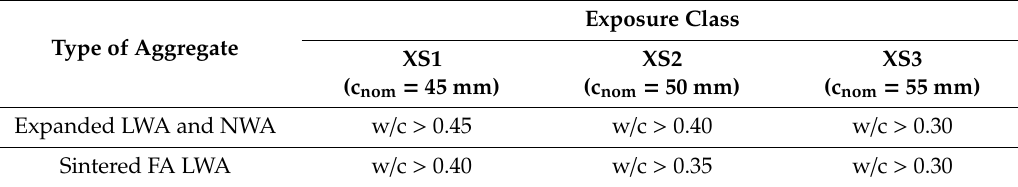
Table 6. Minimum w / c for SLWAC and NWC with intended design service life of 50 years under chloride-induced corrosion, proposed by [138]